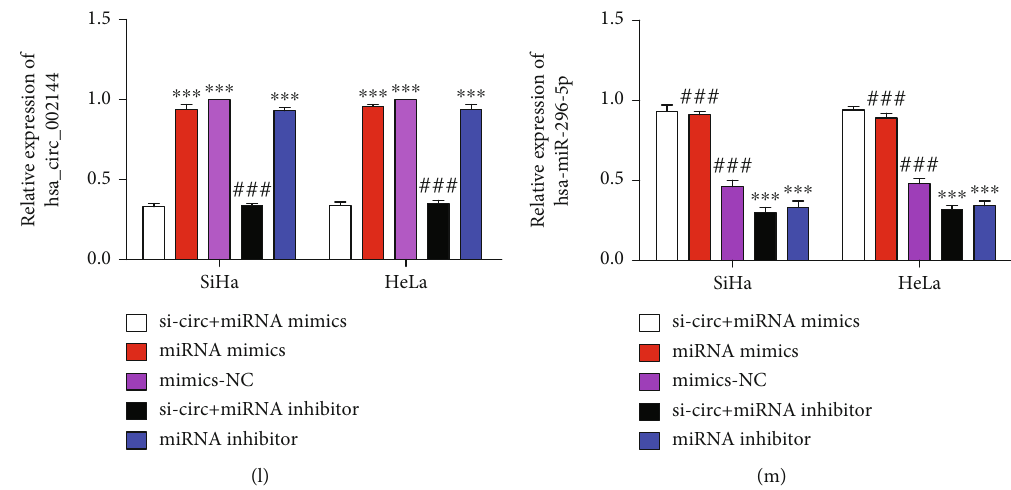
Figure 3: hsa_circ_0000511 promoted the invasion and migration of SiHa and HeLa cells by regulating hsa-miR-296-5p. Contrary to hsa_ circ_0000511, the expression of hsa-miR-296-5p in SiHa and HeLa cells was signi fi cantly lower than that in H8 and C-33A cells (a) ( mean ± SD ; the data were analyzed by one-way analysis of variance, vs. H8, ∗∗ p < 0.01; vs. C-33A, ## p < 0.01), and that was increased when hsa_circ_0000511 was silenced (b) ( mean ± SD , the data were analyzed by an unpaired two-sided t -test, vs. the control, ∗∗ p < 0 : 01 ; vs. si-circ-NC, ## p < 0 : 01 ). The result of dual-luciferase reporter assay (c) shows that hsa-miR-296-5p is a direct target of hsa_circ_ 0000511 in SiHa (d) and HeLa (e) cells ( mean ± SD ; the data were analyzed by one-way analysis of variance; vs. circRNA-wt+miRNA NC, ∗∗ p < 0 : 01 ). The proliferation (f, g), invasion (h), and migration (i) of SiHa and HeLa cells were increased because hsa-miR-296-5p was regulated by hsa_circ_0000511; that is to say, the number of cells in a lower Transwell chamber was increased signi fi cantly (j, k). In addition, the expression of hsa-miR-296-5p (l) changed when whether hsa_circ_0000511 (m) was silenced or not. (f, g, j – m) Mean ± SD ; the data were analyzed by one-way analysis of variance; vs. si-circ+miRNA mimics, ∗ p < 0 : 05 , ∗∗ p < 0 : 01 , and ∗∗∗ p < 0 : 001 ; vs. miRNA mimics, # p < 0 : 05 , ## p < 0 : 01 , and ### p < 0 : 001 ; vs. mimics NC, ^ p < 0 : 05 , ^^ p < 0 : 01 , and ^^^ p < 0 : 001 ; vs. si-circ+miRNA inhibitor, && p < 0 : 01 and &&& p < 0 : 001